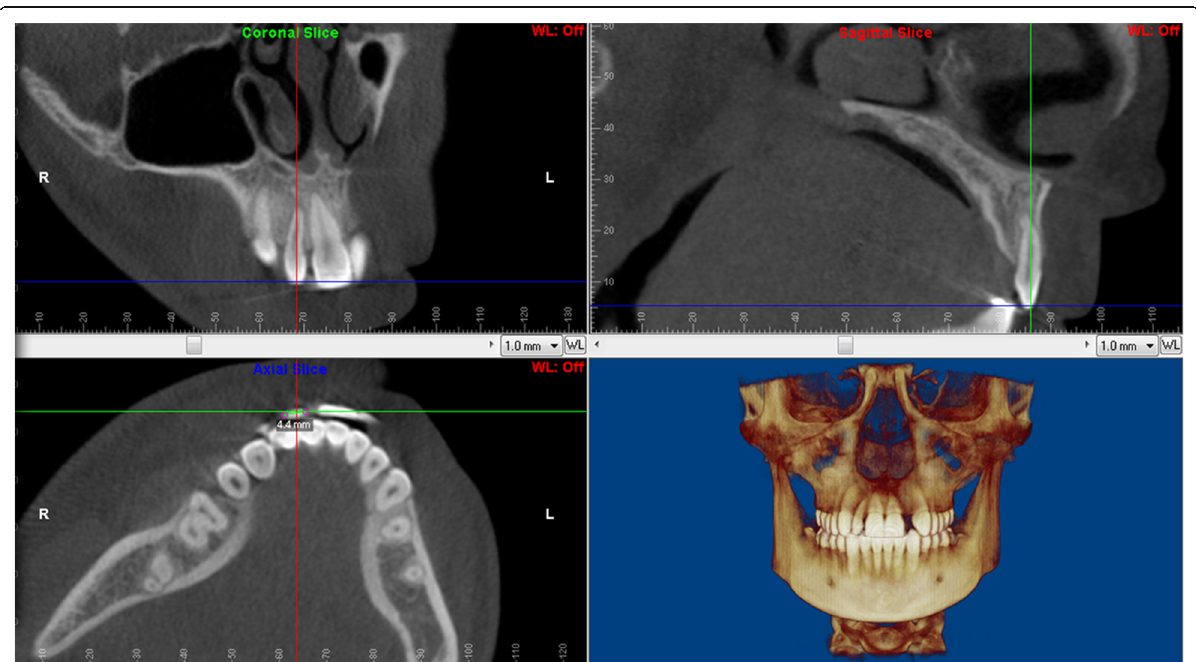
Fig. 6 The multiplanar, sagittal, coronal and axial views parallel to long axis of the tooth used to measure the incisal edge on axial